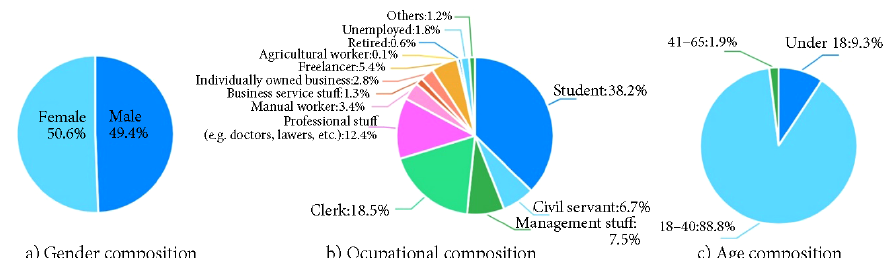
Figure 3. The socio-demographic profile of